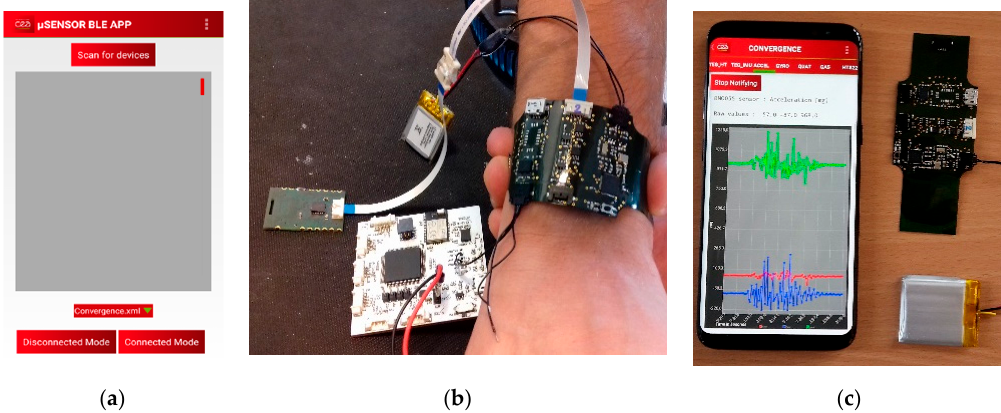
Figure 9. ( a ) Application interface ( b ) Flexible sensor platform tested with ISFET and activity sensor from EPFL and EDI—( c ) Flexible sensor platform tested with embedded sensors.